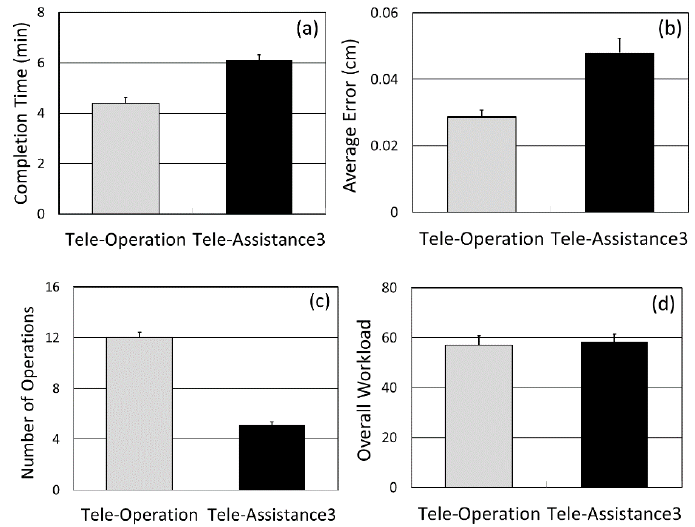
Figure 6. Results of Experiment II: ( a ) Average completion time of the task; ( b ) Average error of performing the task; ( c ) Average number of operations executed by the participants; ( d ) Average workload perceived by the participants. (Error bars represent standard error).